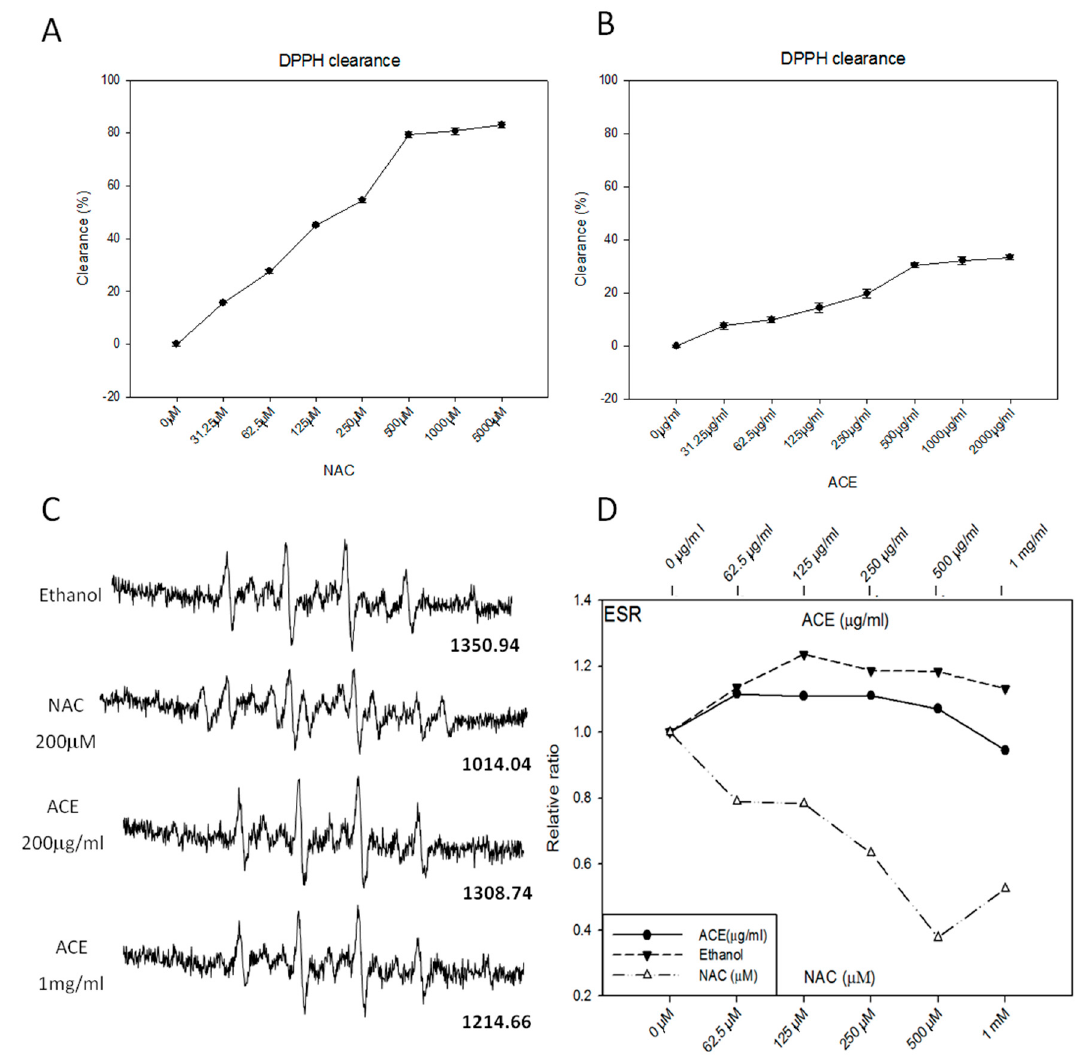
Figure 3. Examination of direct free radical-scavenging activities of ACE. DPPH free radical-scavenging activity of N -acetyl- L -cysteine (NAC) ( A ) and ACE ( B ) were analyzed. Results were obtained from three independent experiments, each experiment was done in triplicate. The ESR spectra of 5,5-dimethyl-1-pyrroline-N-oxide (DMPO) in phosphate buffered saline (PBS) were measured in the presence or absence of ACE or ( N -acetyl- L -cysteine) (NAC) (200 µ M) ( C ) and plotted and compared in a dose-dependent manner ( D ).